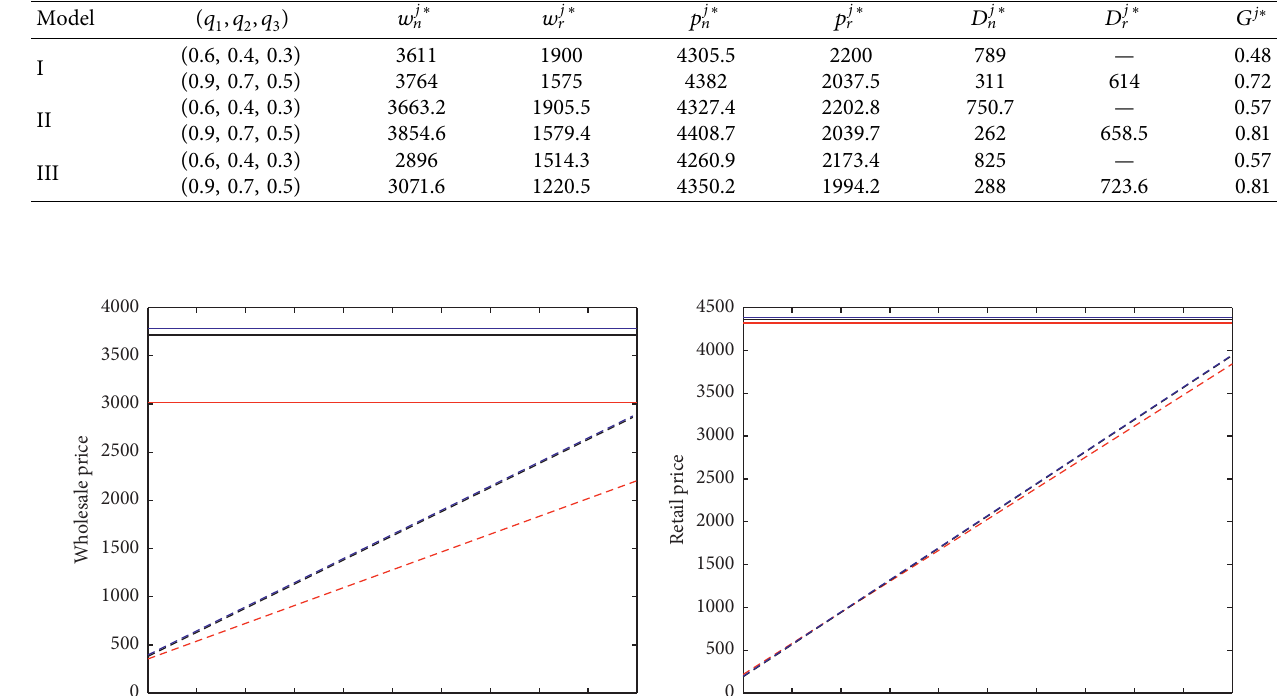
Table 6: Equilibrium results under different q